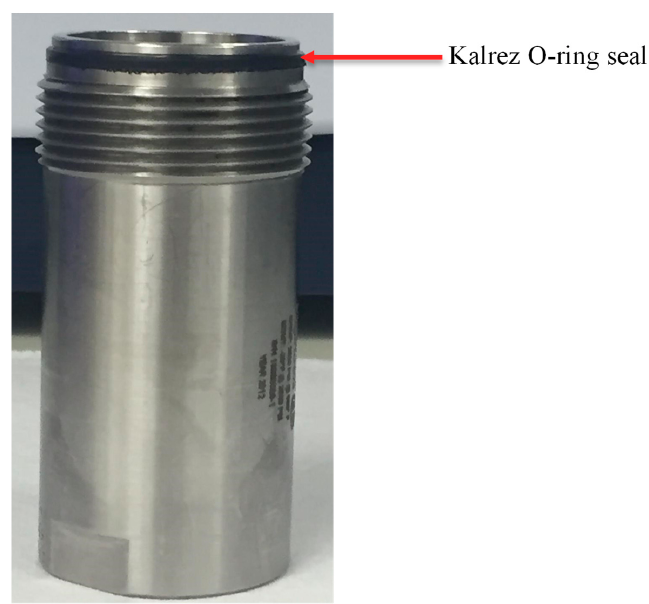
Figure 2. A photograph of the autoclave cell showing the position of the O-ring elastomer.